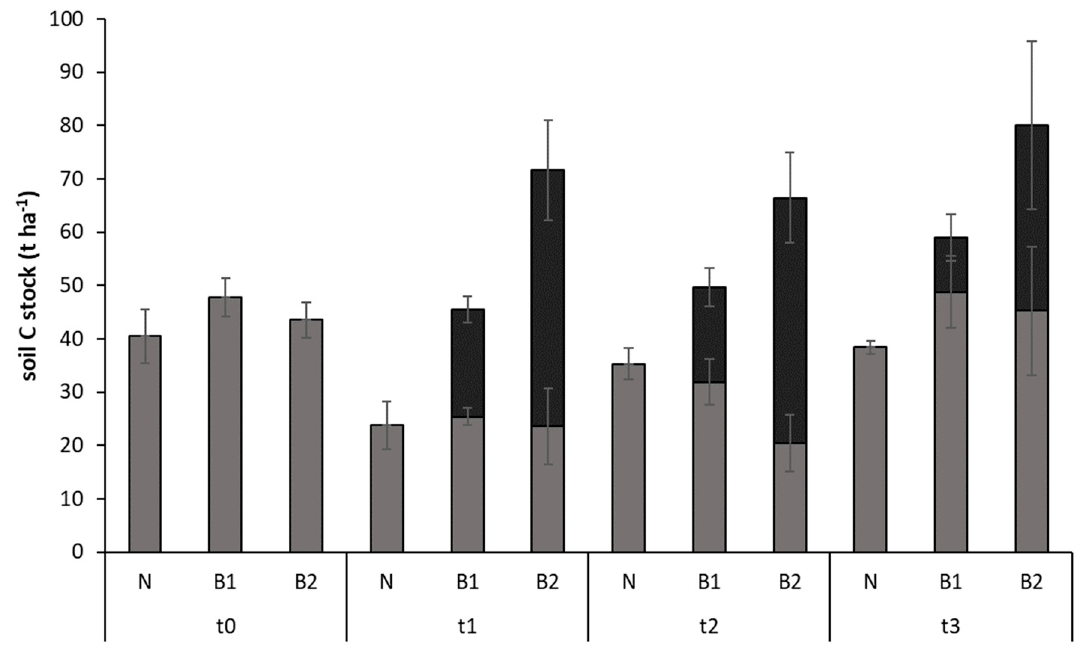
Figure 6. Soil C stock (t ha − 1 ) divided into biochar-C (black bars) and SOM-C (gray bars) as assessed with the isotopic mass balance method. C stocks are reported for three experimental treatments: N (control), B1 (25 t ha − 1 biochar), B2 (50 t ha − 1 biochar) before the application of soil amendments (t0), 3 weeks later (t1), 1 year later (t2) and 2 years later (t3). No statistically significant differences were observed ( p ≤ 0.05). Vertical bars represent the standard error of the mean.